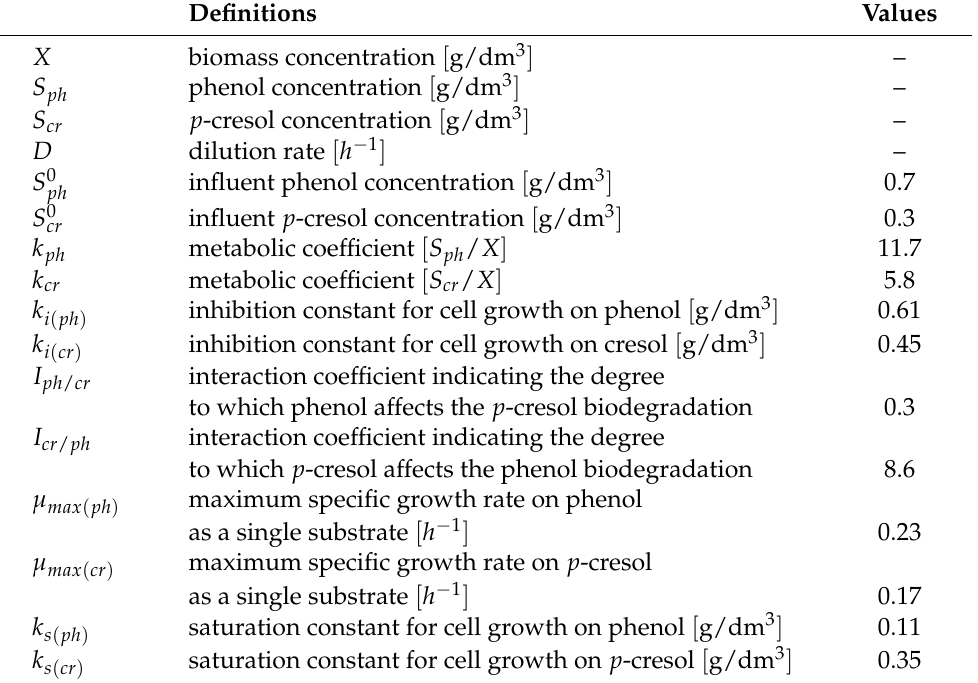
Table 1. Model variables and